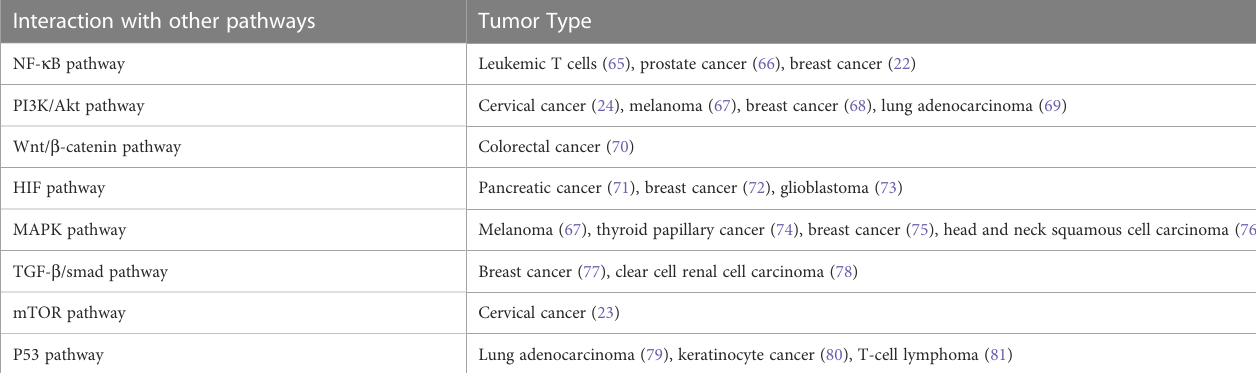
TABLE 2 The cross-talk between Notch signaling and other pathways in cancers. Interaction with other